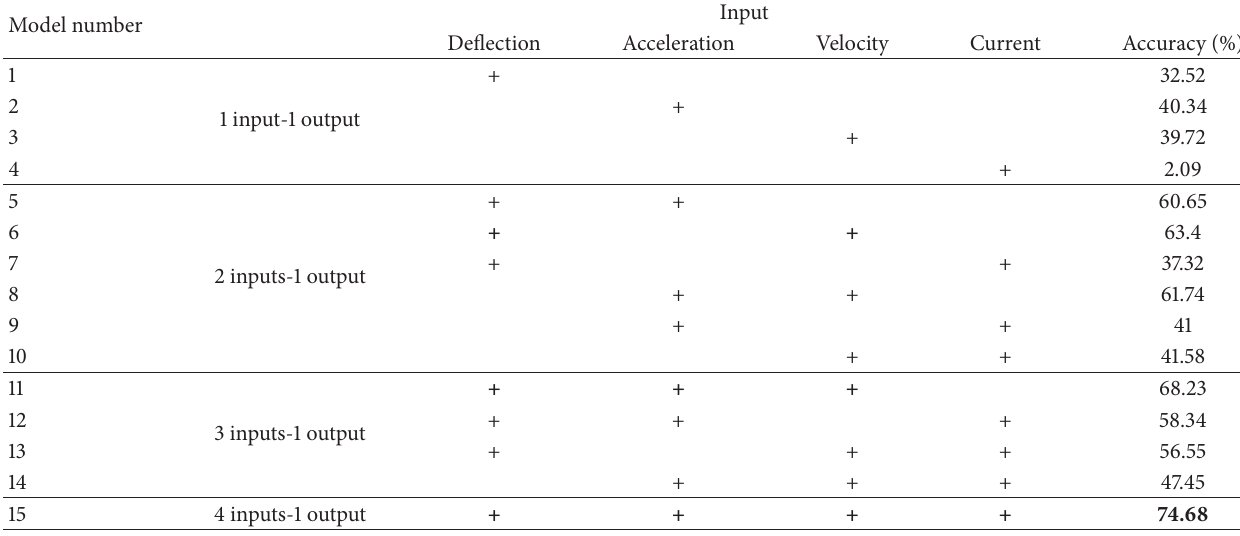
Table 5: Simulation parameter studies for neurofuzzy models.